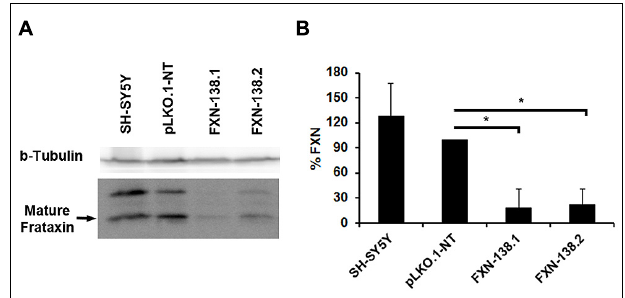
FIGURE 1 | Depletion of frataxin by siRNA. SH-SY5Y cells were transfected with the vector pLKO-FXN.Two SH-SY5Y stable clones exhibiting the most efficient silencing were selected, FXN-138.1 and FXN-138.2. (A) Cell lysates were analyzed by SDS-PAGE and immunoblotting for frataxin (bottom panel; upper and lower bands correspond to intermediate and mature forms of frataxin, respectively). Beta-tubulin was used as a loading control (top panel). (B) Bands corresponding to mature frataxin were quantified and final values are expressed as a percentage of the pLKO.1-NT value. Student’s t -test, FXN-138.1 p = 0.025 , FXN-138.2 p = 0.019 versus pLKO.1-NT. * p ≤